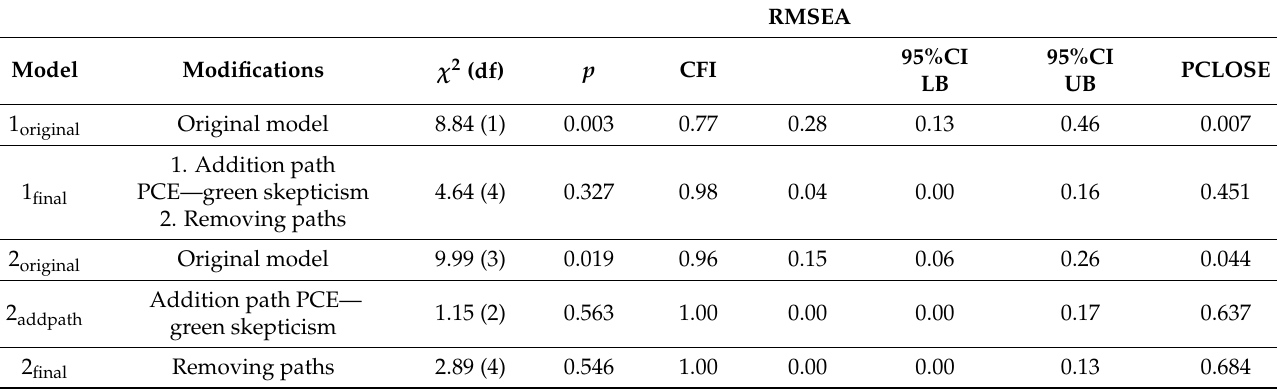
Figure 2. Final path model to test H1b through H3b (Model 1). Note: ** Relationship is significant at the 0.01 level. Unstandardized coefficients are reported. General environmental attitude is included as control variable but not shown for reasons of clarity. Model fit: χ 2df=4 = 4.64, p = 0.327, CFI = 0.98, RMSEA = 0.04, 90%CI = [0.00, 0.16], PCLOSE = 0.451.